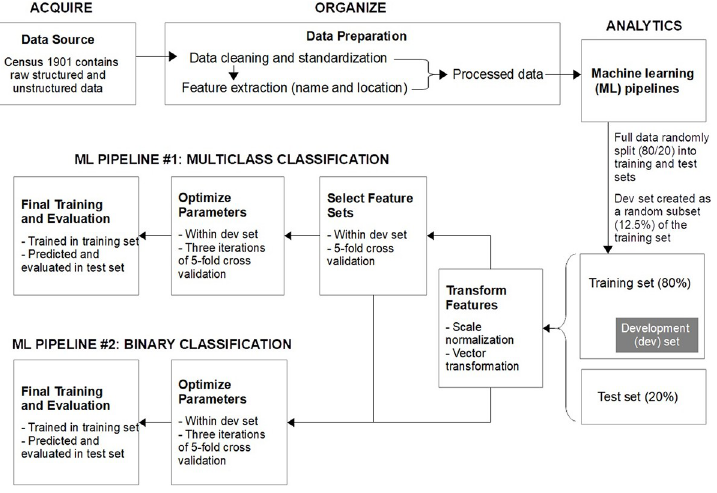
Fig 1. Overview of the machine learning